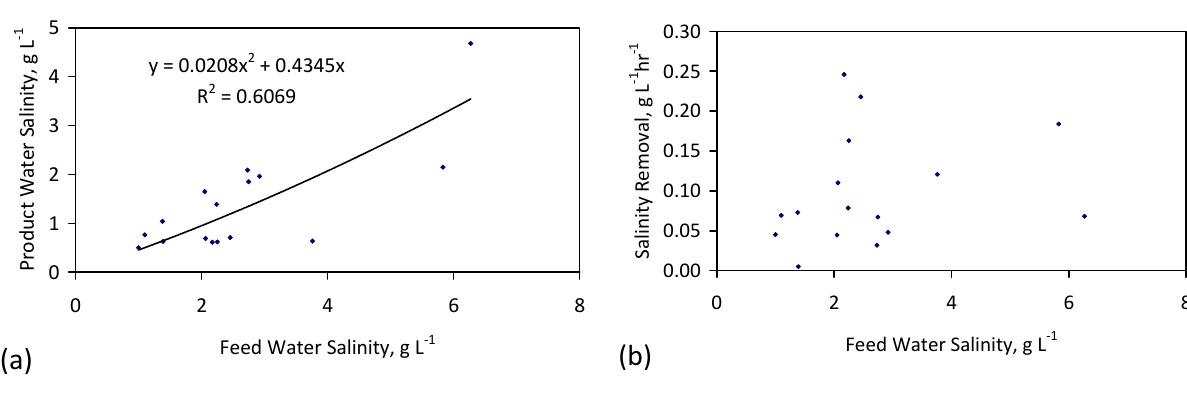
Figure 20. ZVM TPA example for the Trial Series E146a to E146q (Table C13). ( a ) Relationship between feed water salinity and product water salinity; ( b ) Relationship between feed water salinity and the rate of salinity